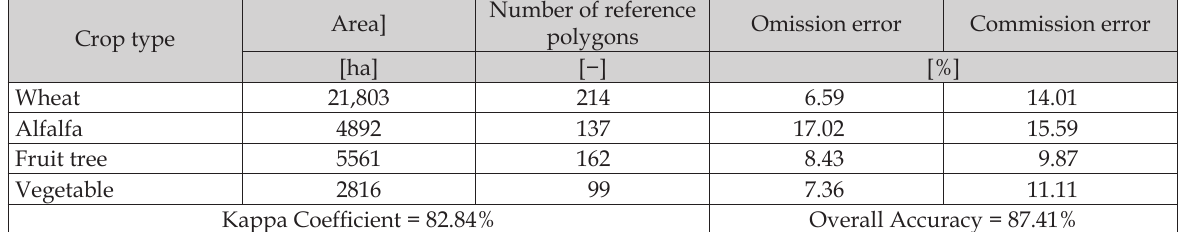
Table 3. The area of crops and the results of accuracy assessment.